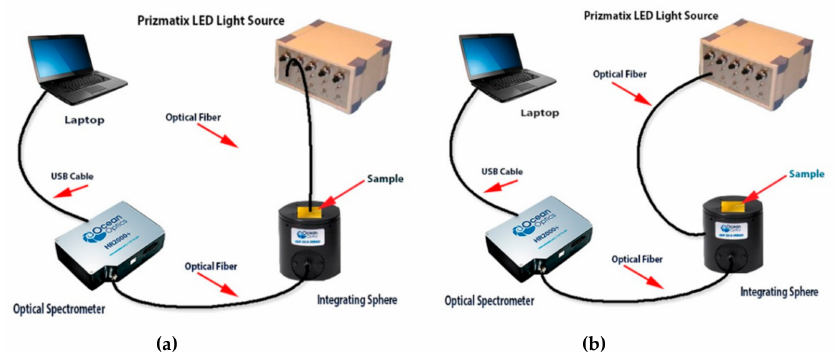
Figure 2. Experimental setups for the UV irradiation of the prepared films: ( a ) The experimental configuration for the measurement of the forward luminescent light produced by the sample, as well as the UV radiation that pass through the sample and ( b ) the experimental configuration for the measurement of the reflected UV, as well as the backward luminescent light produced by the